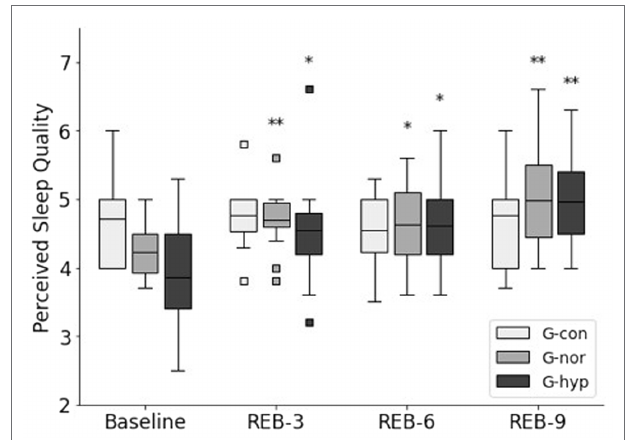
FIGURE 3 | Changes in perceived sleep quality throughout the Rebalance© Program. G-con, control group; G-nor, normotensive group; G-hyp, hypotensive group. Baseline, 3-day data collection period prior to Rebalance© session 1; REB-3, − 6, − 9, 3-day data collection period following Rebalance© session number 3, 6, and 9, respectively. Box plots represent median interquartile range (IQR, Q25–Q75), and error bars are maximal and minimal observations within 1.5 × IQR. Squares represent maximum and minimum observations above or below 1.5 × IQR. * and ** Significantly different from Baseline ( p < 0.05 and p < 0.01,